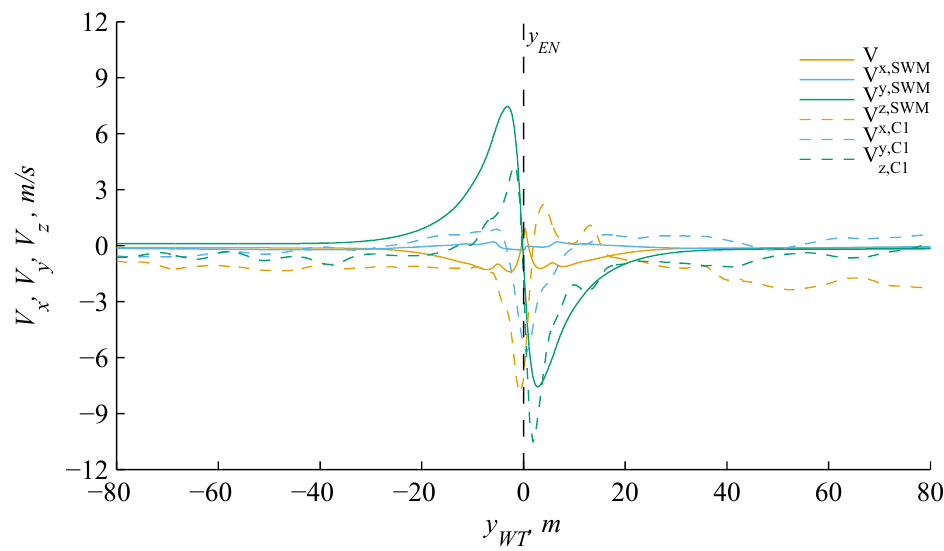
Figure 15. Comparison between the airwake velocities ( V x , V y , V z ) of C1 and SWM at position 2.